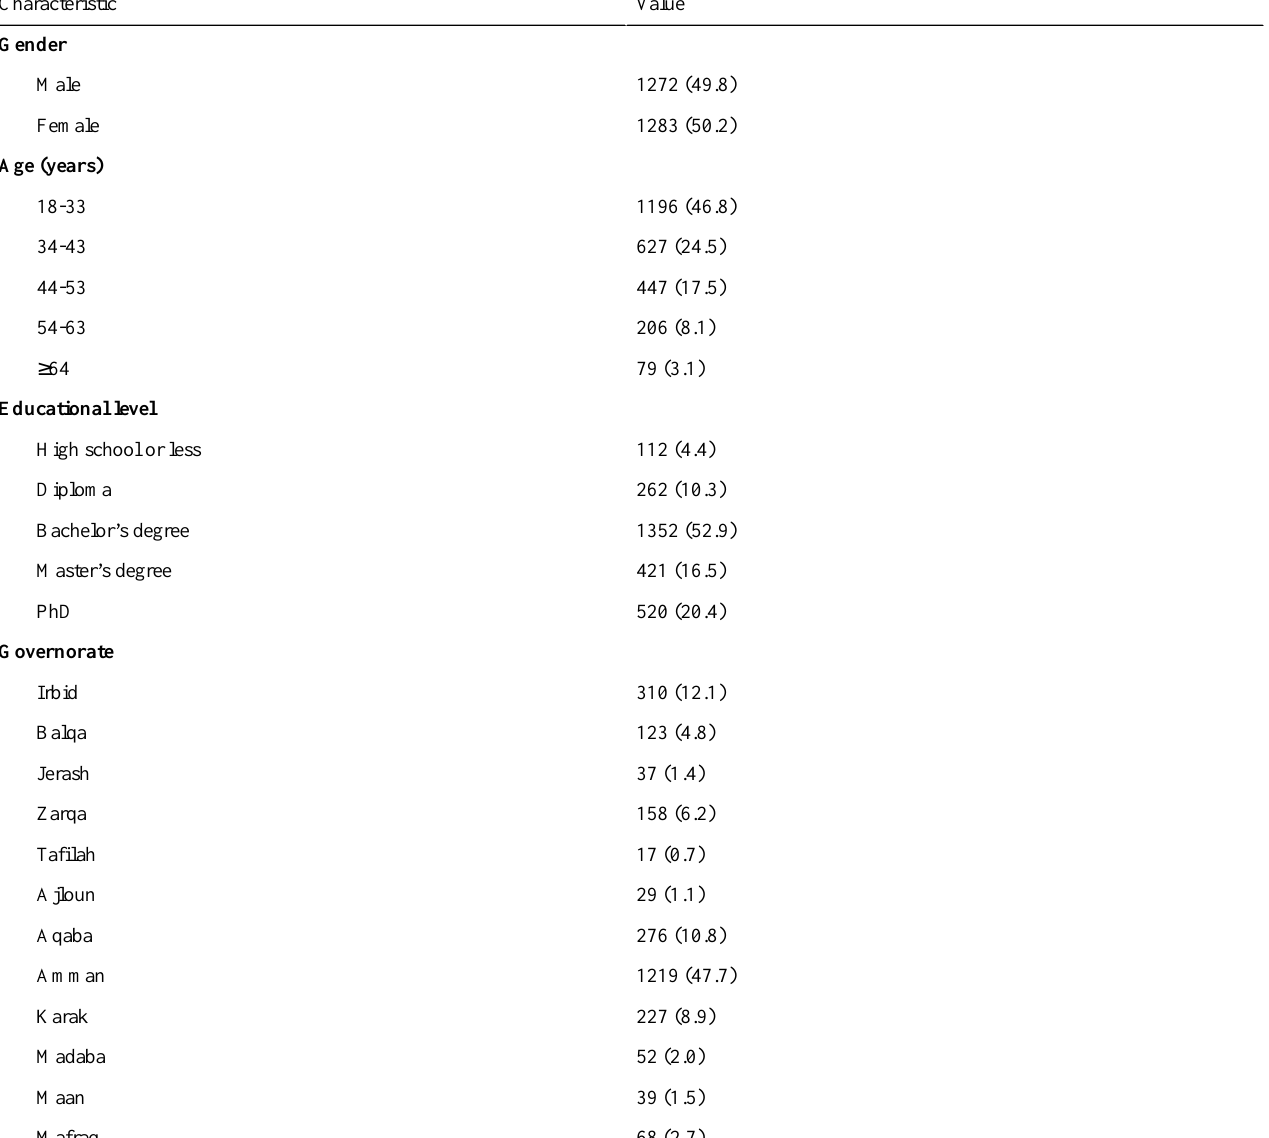
Table 2. Sample profile (N=2555), n